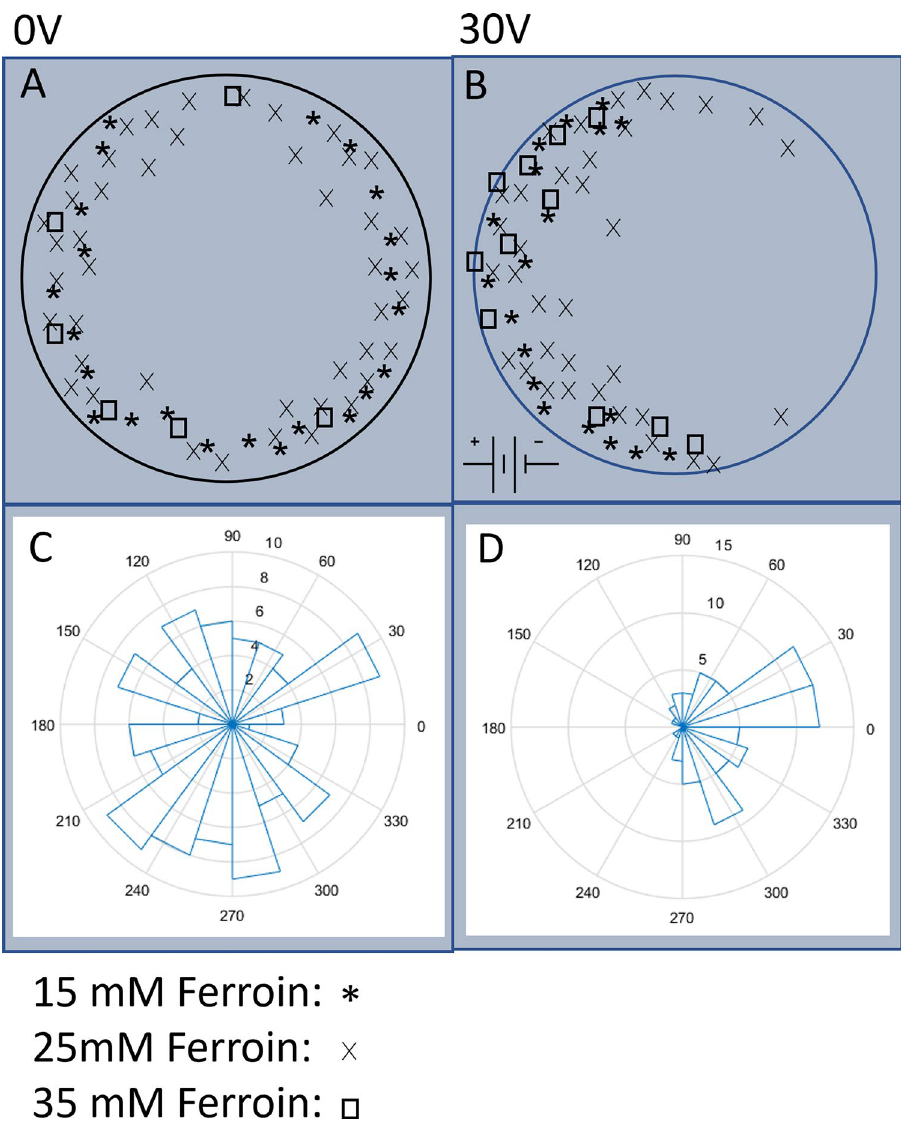
Figure 8. Effect of the Ferroin concentration on the electrotaxis of BZ droplets. ( A , B ) Distribution of the leading centers within an aqueous droplet under the application of an external DC electric field with strength 3.3V/cm, applied from left to right. ( B ), and for the control case with no external field applied ( A ). Experiment data obtained from droplets containing Ferroin concentrations of 15 mM, 25 mM and 35 mM are shown with an asterisk (*), cross (x) and open square symbols, respectively. ( C , D ) Circular histogram of the travelling angle of chemically driven translational motion of BZ droplets. The electric field was applied with the positive electrode on the left, and the negative electrode on the right. The field-induced biased distribution of LC formation in favour of the positive electrode is prominent when comparing ( B ) with ( A ). The data also shows that the taxis effect is insensitive to the Ferroin concentration. Data points were collected from 147